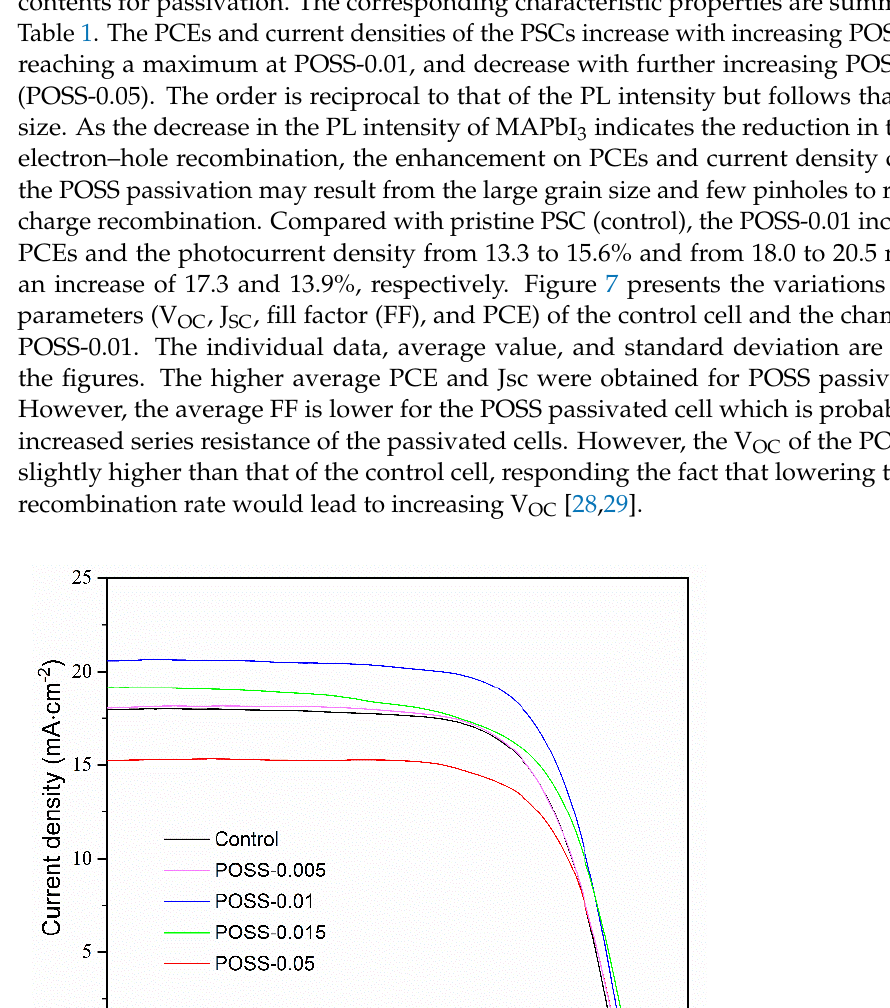
Figure 5. Photoluminescence spectra (PL) spectra of the FTO/NiO X /POSS/MAPbI 3 with various